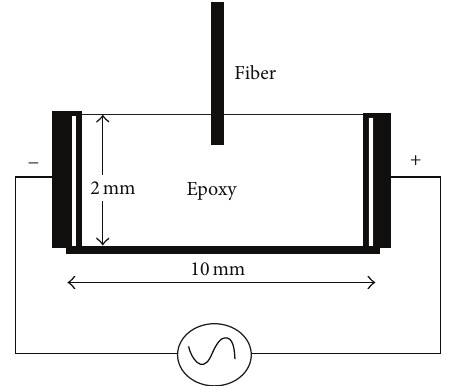
Figure 1: Treatment of AC electric fields during epoxy